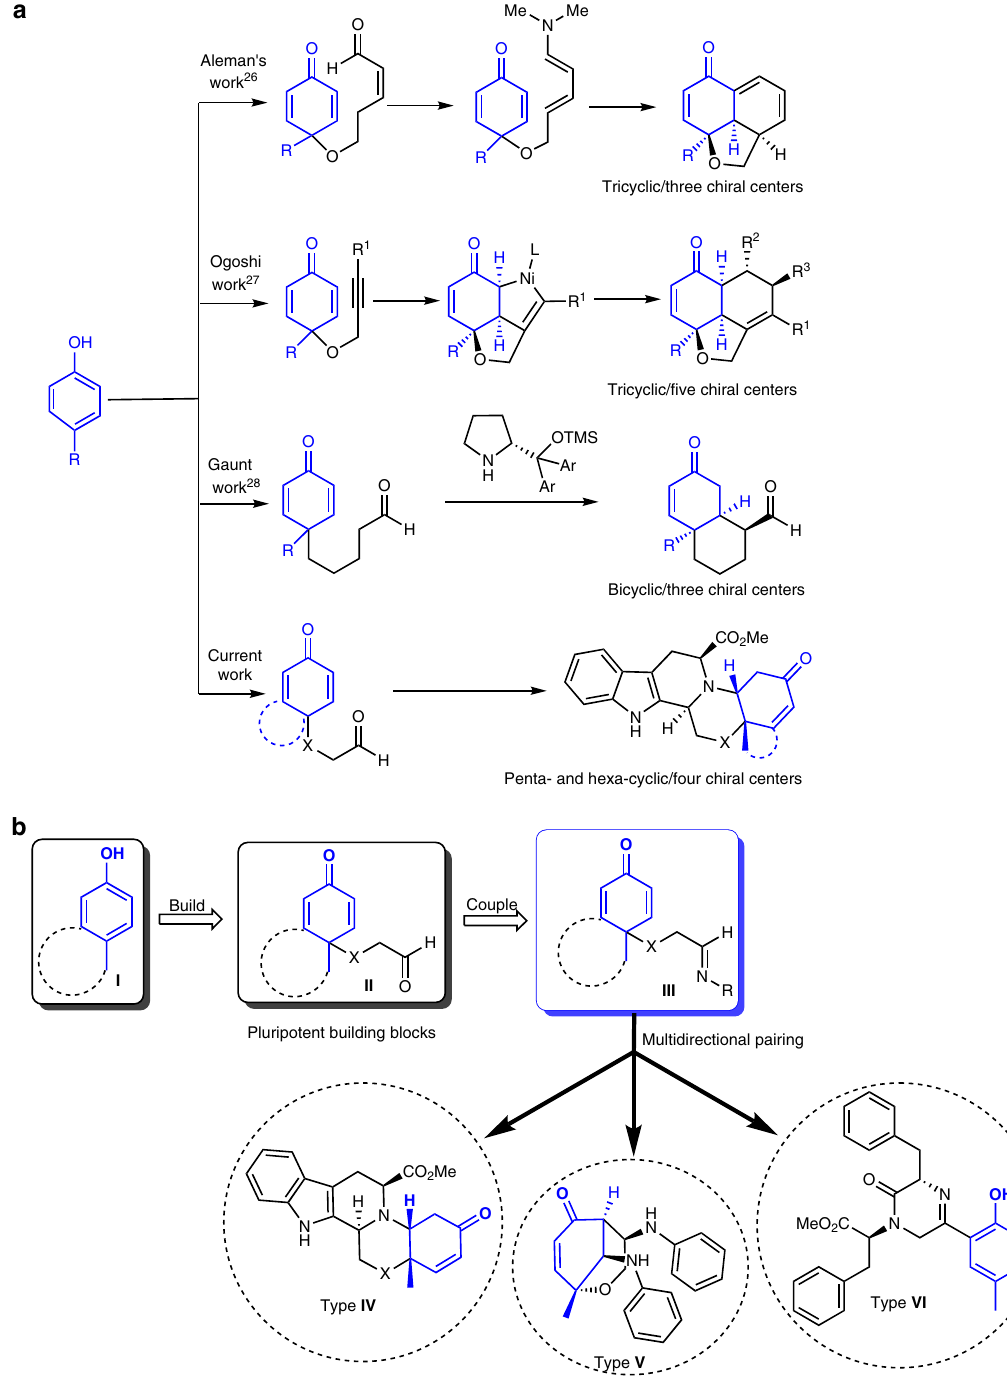
Fig. 2 Multidirectional utilization of oxidative-dearomatization building blocks. a Previous and current approaches utilizing the building blocks derived from oxidative-dearomatization reaction. b Three-directional build/couple/pair strategy for the access of diverse molecular